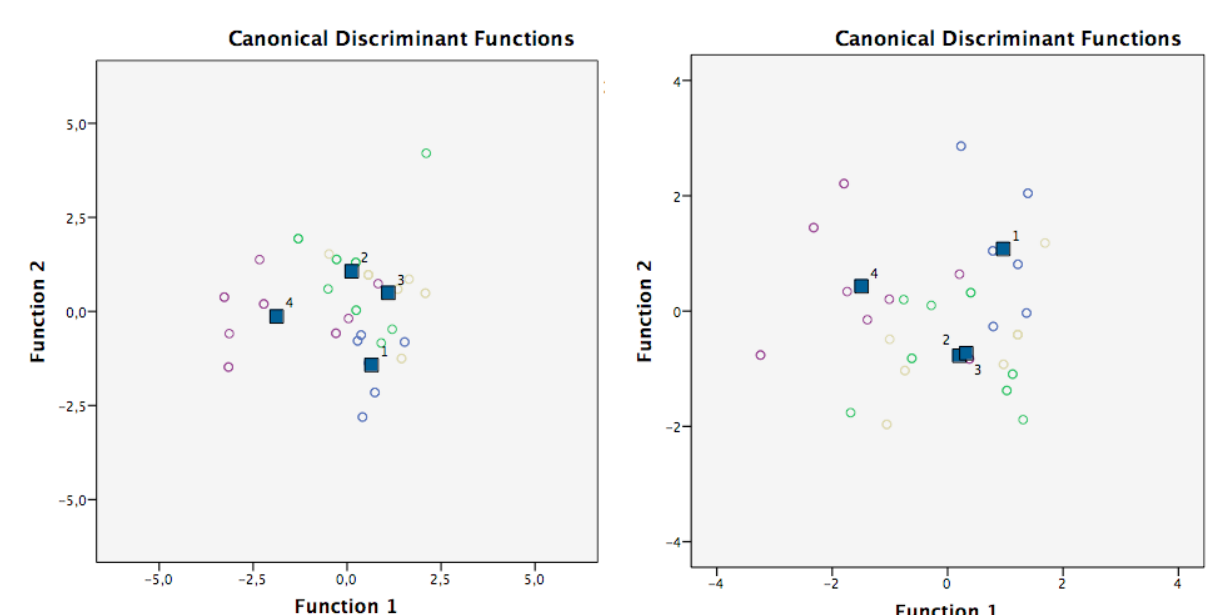
Fig. 3. Dynamics of test results in boys aged 8. CTE9: 1 – load variant І, 2 – load variant ІІ, 3 – load variant ІІI, 4 – load variant ІV